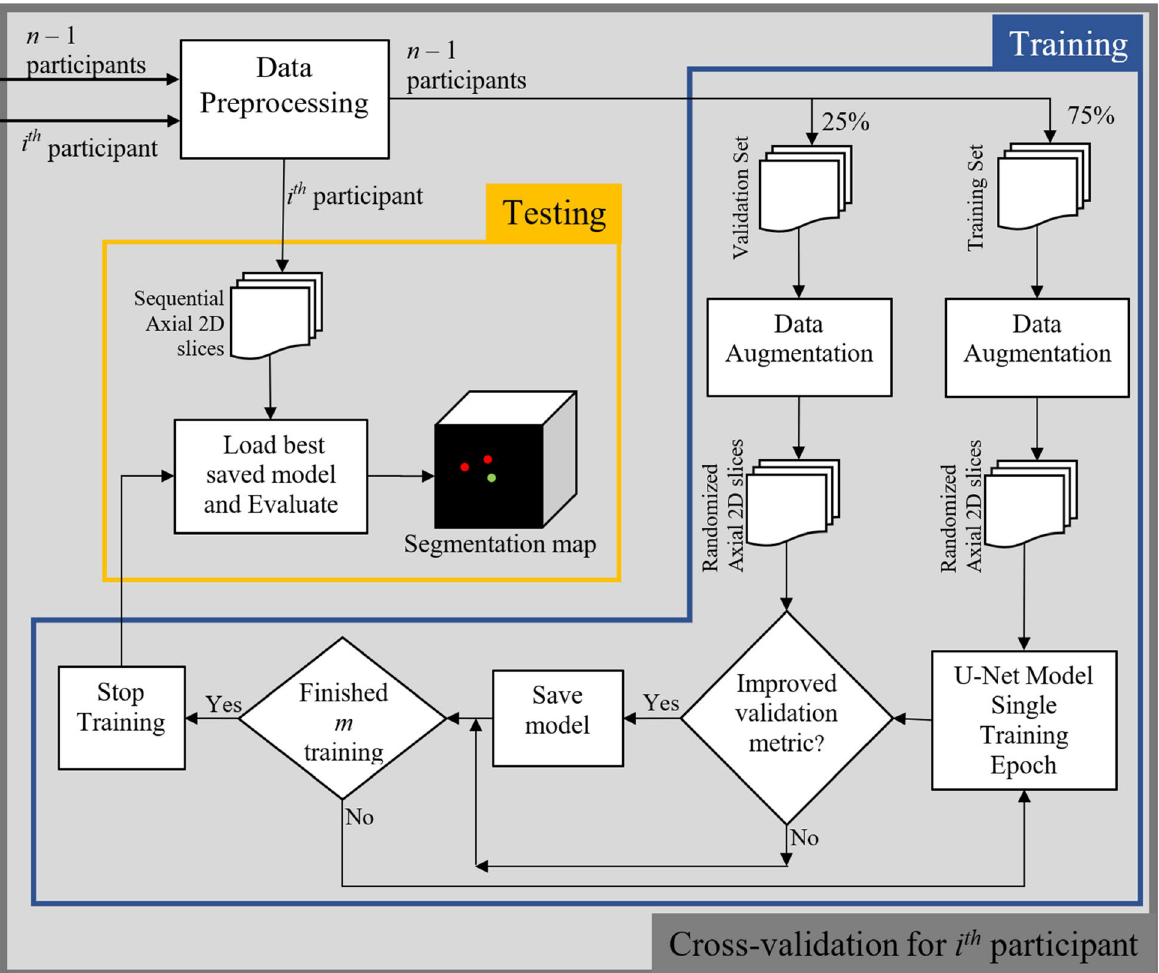
Figure 5. Overview of the cross-validation process (one-fold) that is repeated n times. In each fold, the model that was used to predict the test participant was trained on the remaining n − 1 samples in order to avoid data leakage. Within the training stage, 25% of the n − 1 participants were used as the validation set. The model with the highest validation accuracy was chosen to predict the left-out participant